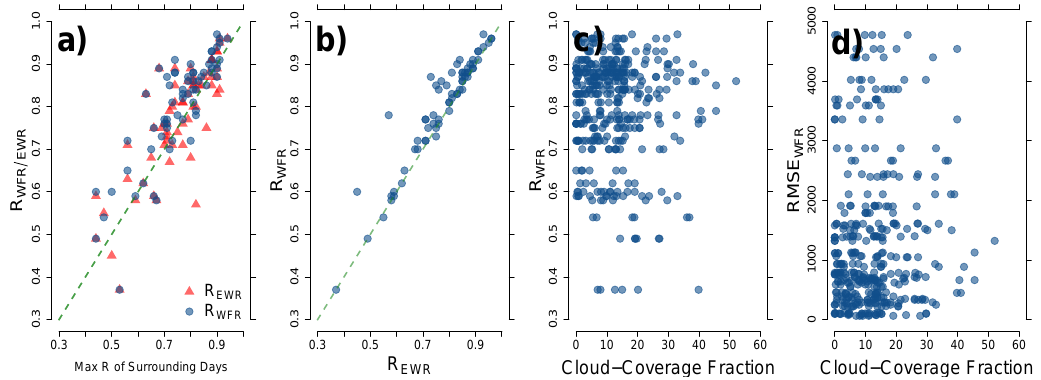
Figure 5. Summary of differences between weighted WFR -CMB1 and equally-weighted 6 d EWR -M2 approaches. ( a ) Scatterplot of the resulting spatial correlation coefficients R 6 d WFR and R with the day of interest against the maximum spatial correlation of any of EWR the six surrounding days with the initial day of interest. ( b ) Scatterplot of R against WFR R . ( c , d ) Scatterplots of WFR -CMB1 achieved R and RMSE against the present cloud EWR 6 d coverage in the surrounding six